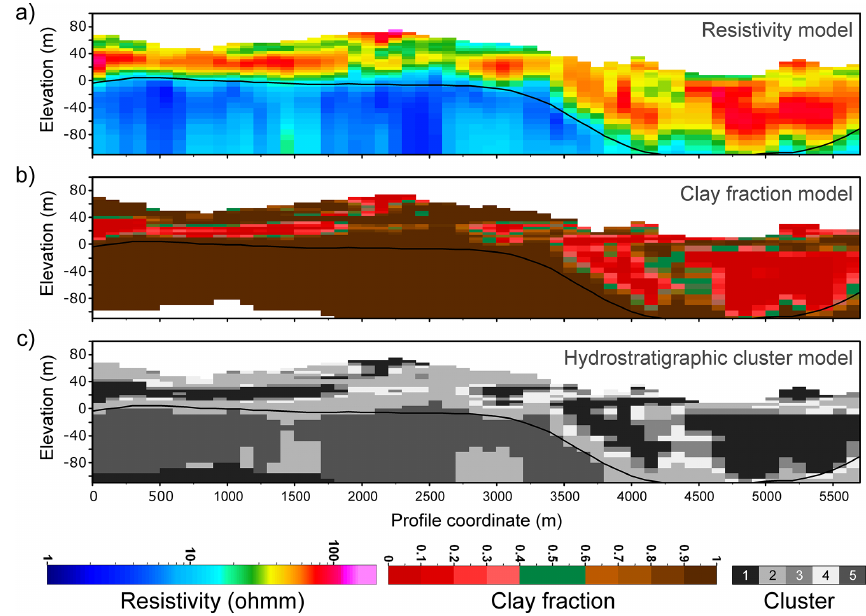
Figure 2. Northwest–southeast profiles (vertical exaggeration × 5), location is marked in Fig. 3. (a) Resistivity model, (b) clay-fraction model, and (c) hydrostratigraphic cluster model for the 5-cluster case.